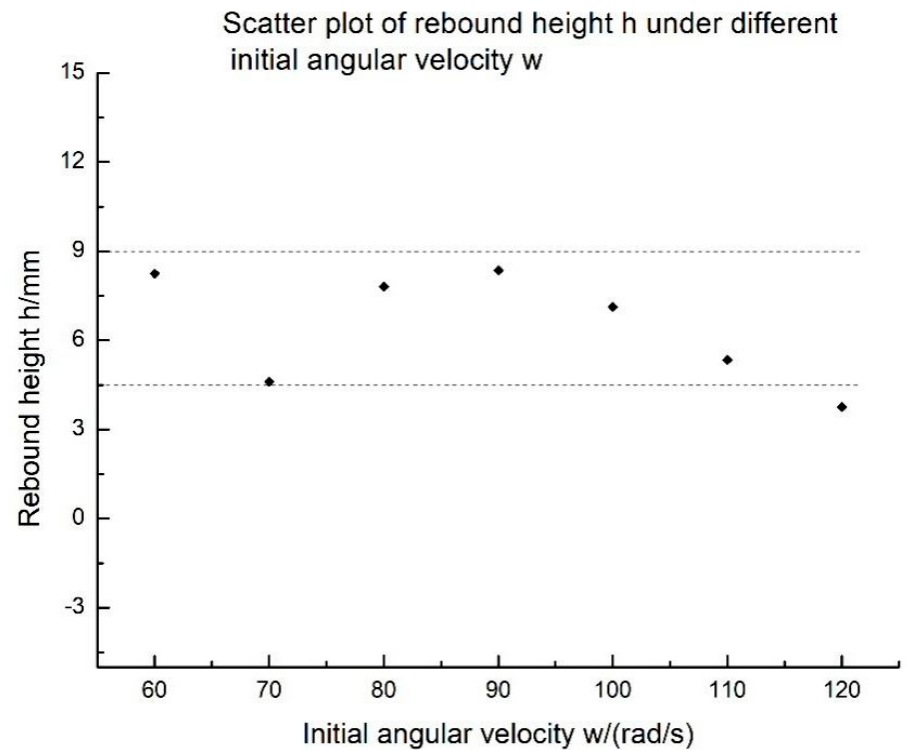
Figure 9. Scatter diagram of the rebound height h at different initial angular velocity w of three-section cudgel.